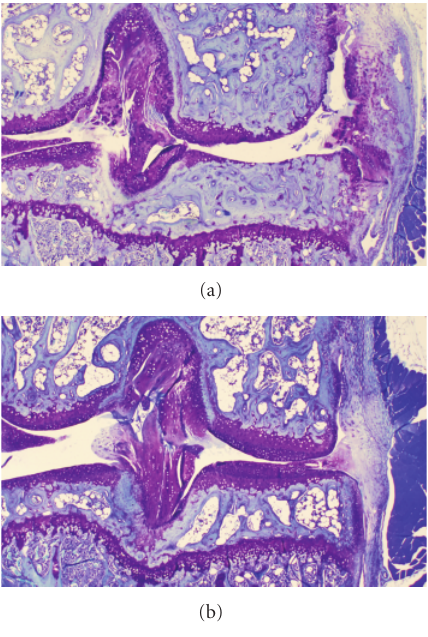
Figure 4: Representative histology images of articular cartilage from 8-month-old STR/ort mice that were treated with GS 200mg/kg (b) or vehicle (a) for 3